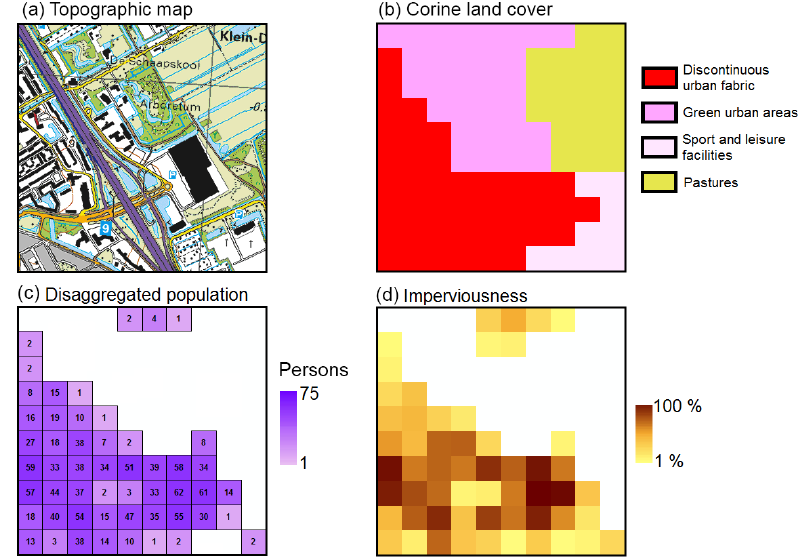
Figure 2. Disaggregation result and source data for a fragment of the city of Delft in the Netherlands. The area shown corresponds to a 1km grid in the GEOSTAT population data set. In this grid cell, the population at the time of the 2011 census was 1218. Panel (a) was extracted from a Dutch 1 : 25000 topographic map for reference. Panel (b) shows the land use structure according to CORINE Land Cover 2012, and panel (d) shows soil sealing according to Imperviousness 2012 data set. The final disaggregated 100m population grid is presented in panel (c) . Table 1. Input variables in